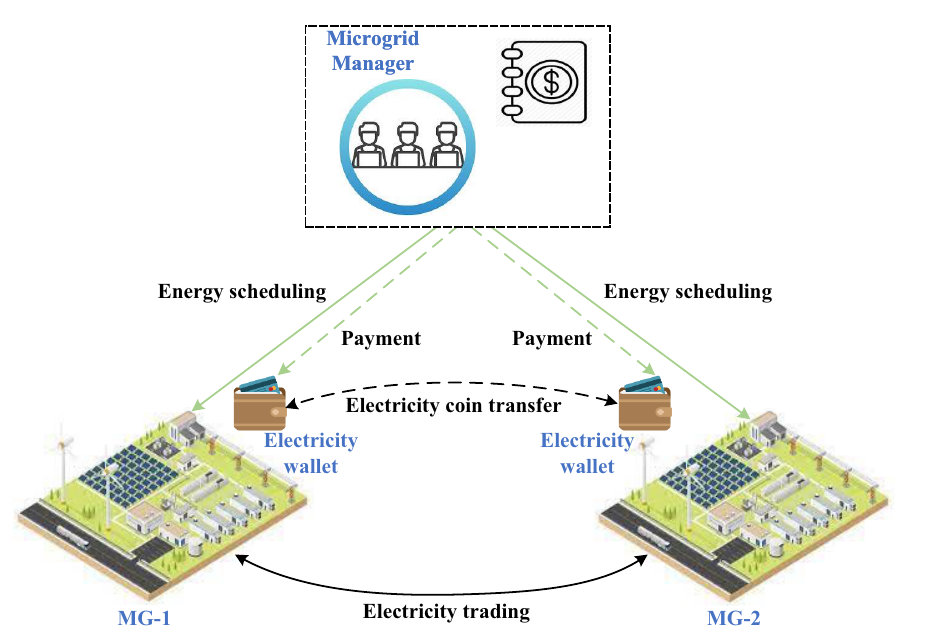
Figure 4. Local electricity trading and electricity coin